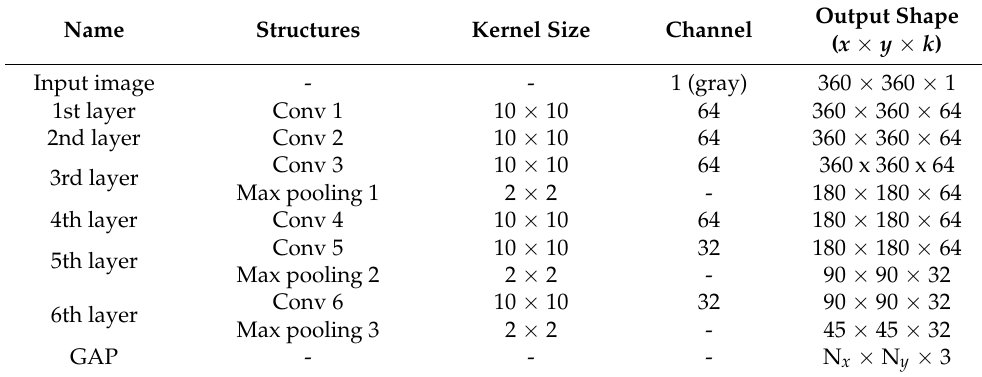
Table 1. Structure and parameters of CNN with CAM.